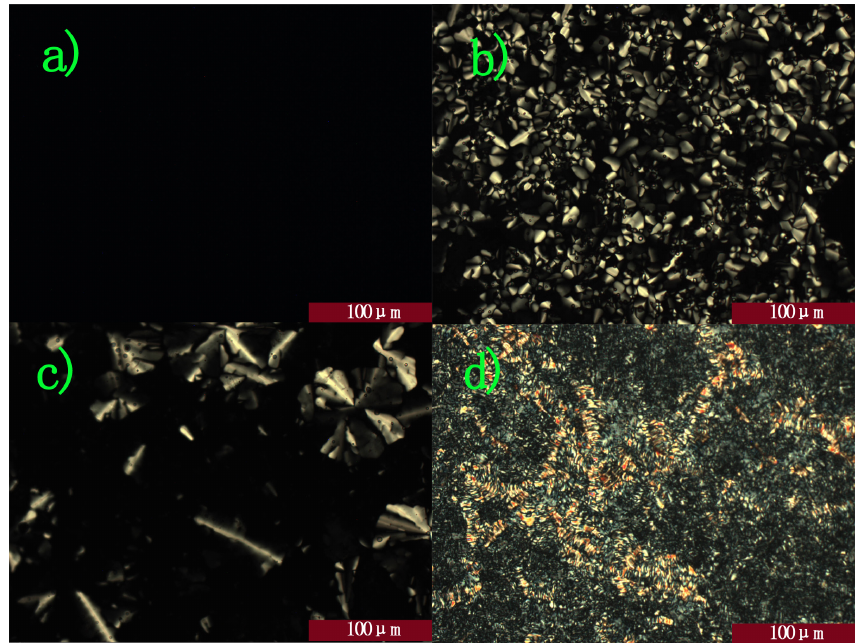
Figure 3. POM of HBC derivative. ( a ) at 85 °C with crossed polarizers; ( b ) 65 °C with crossed polarizers; ( c ) at 60 °C with crossed polarizers for two hours; ( d ) at 25 °C with crossed